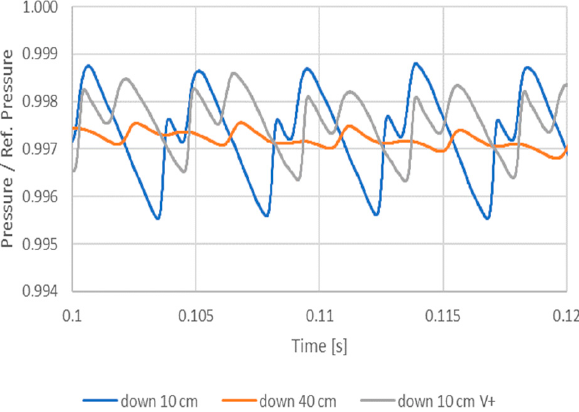
Figure 21. Pressure evolution in the downstream section with di ff erent damper lengths and volume.